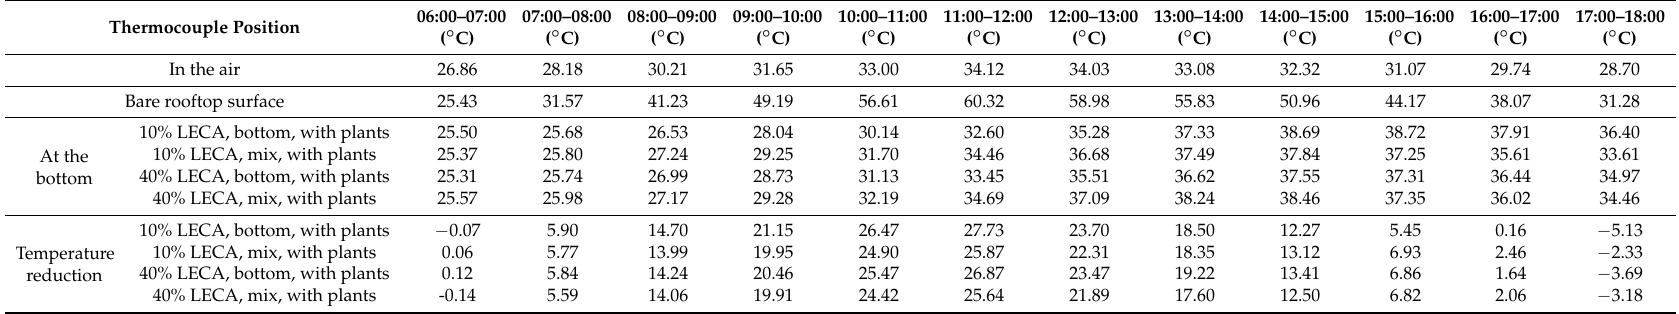
Table 12. Temperatures at the bottom of the roofs and temperature reductions in the cases of the roofs with 10% and 40% LECA laid at the bottom with Ipomoea batatas , and of 10% and 40% LECA mixed with the soil with Ipomoea batatas (1 October 2017 06:07:57 to 1 October 2017 17:57:57). Thermocouple